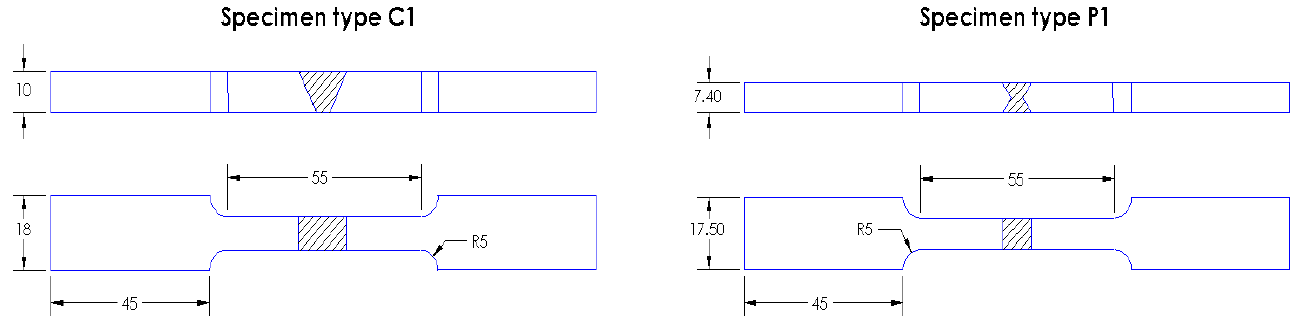
Figure 1. Dimensions [mm] of the specimens for steel 1.4903 (C1) and for Armox 500T (P1). Digital image correlation (DIC) is a powerful non-contact technique for measuring surface displacement/strain fields, [21]. Simple geometric shapes can be treated by 2D analysis, while more advanced, 3D analysis, should be used for more complex geometric shapes, including welded joints, as applied and presented in [22–24]. The force during the experiment was controlled by strain, with the rate 2 mm/min. Setup of the experiment with the position of cameras is shown in Figure 2. Using DIC method with two cameras (3D deformation measurement) and the Aramis software (Version 2M, GOM GmbH, Braunschweig, Germany) the current cross-section area can be determined. Accuracy of this method for strain measurement is very high, in order of micrometers, so it is a suitable method for the experiment performed here.